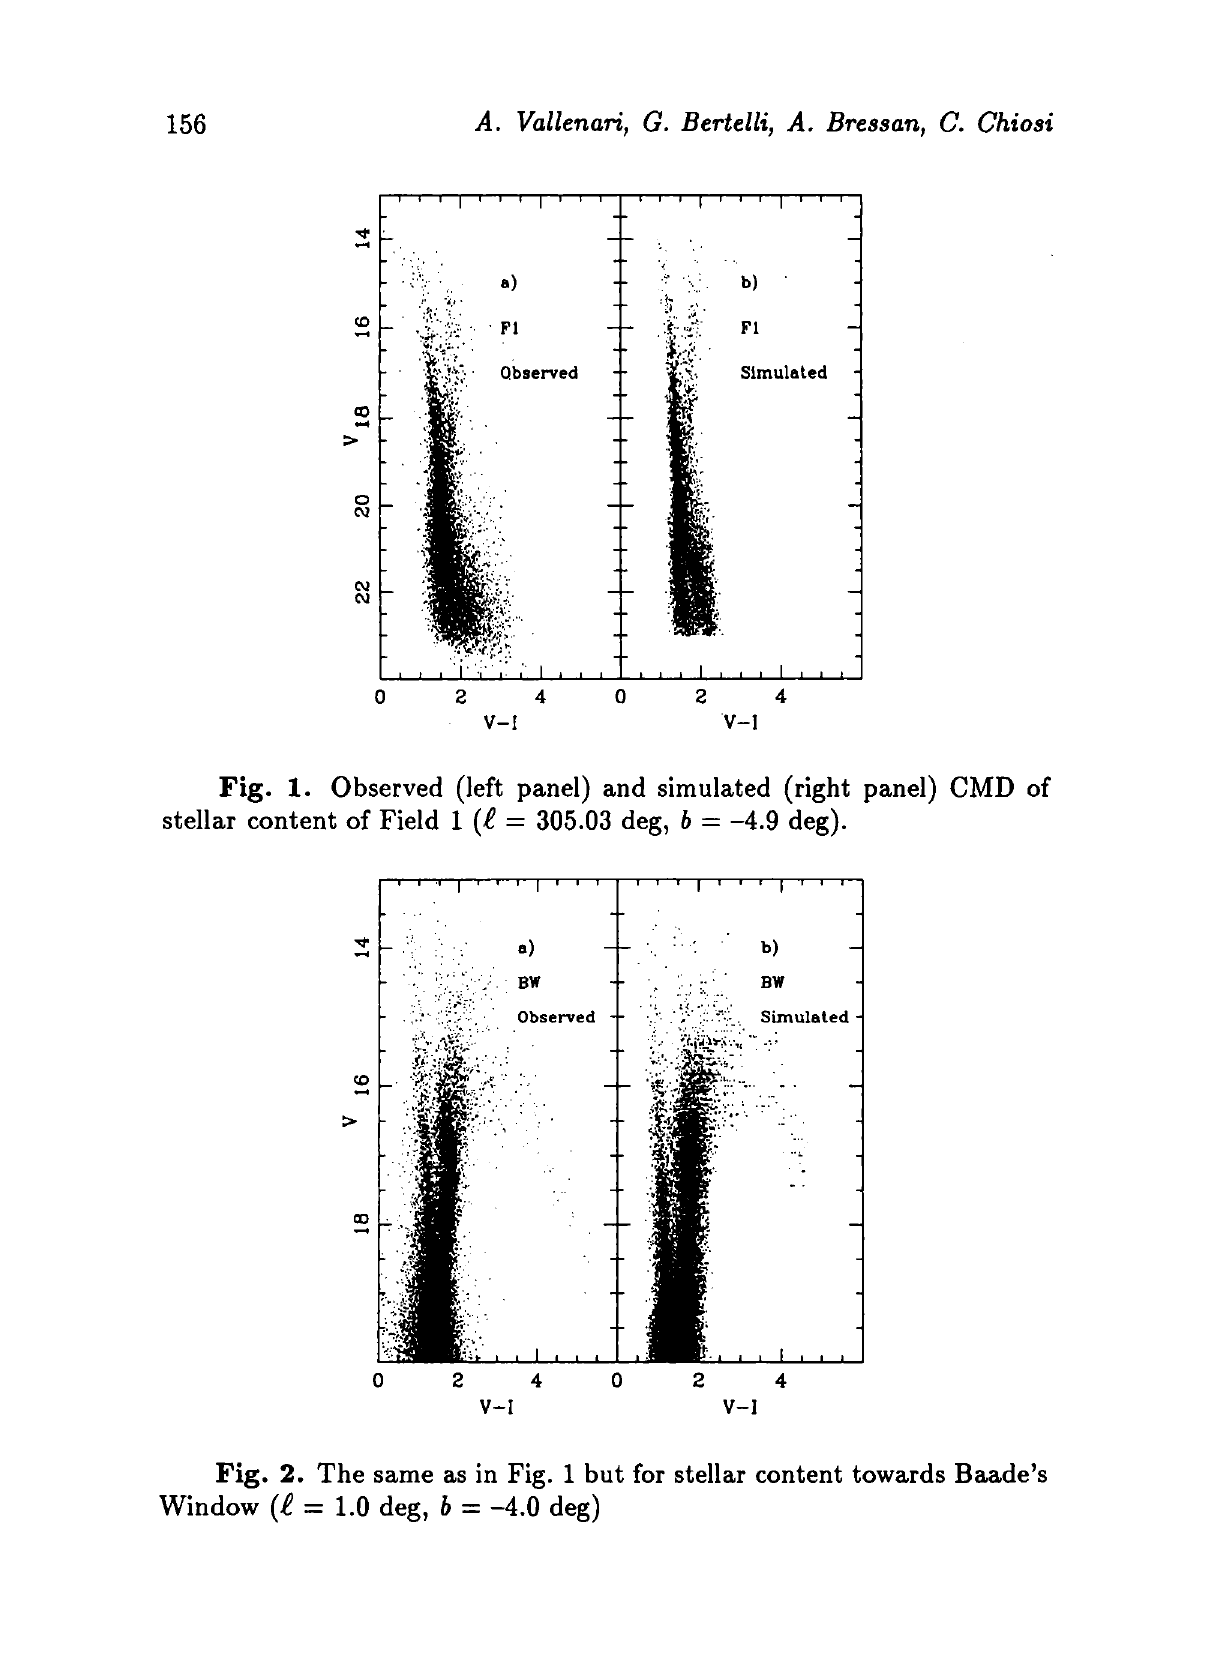
Fig. 2. The same as in Fig. 1 but for stellar content towards Baade's Window (£ = 1.0 deg, b = -4.0